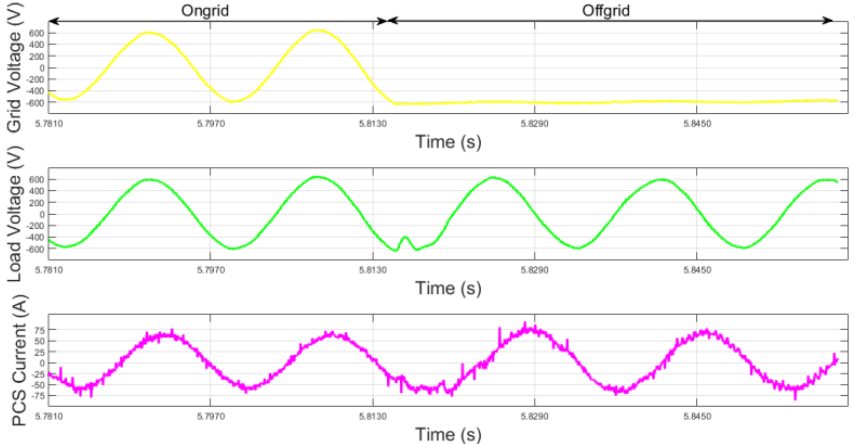
Figure 7. Stage 2: Backup on resistive loads — signal captured by the oscilloscope at the time the backup was simulated.